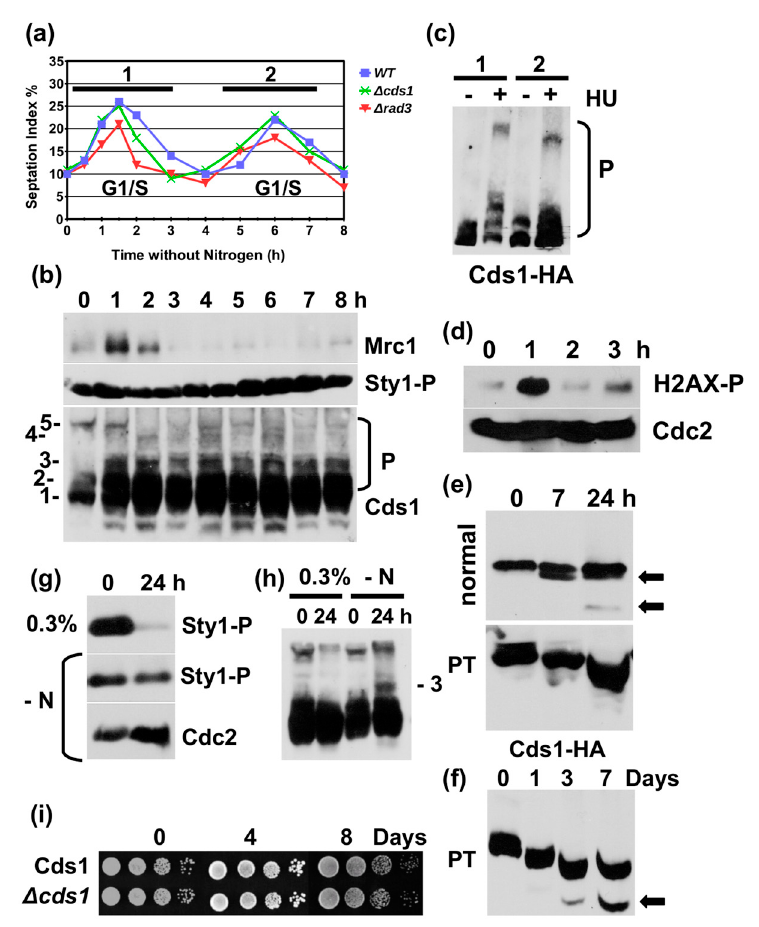
Figure 4. Nitrogen starvation causes similar changes to Cds1 and Mrc1. ( a ) Cds1-HA 2 His 6 , cds1 deletion and rad3 deletion strains without auxotrophic markers were grown in minimal medium with nitrogen overnight, washed and resuspended in minimal medium without nitrogen at 30 °C. The rise in the septation index (G1/S cells) shows the two rounds of DNA replication post-shift. ( b ) Total protein extracts tested at the indicated hours post-shift and probed for Mrc1, Sty1-T171P + Y173P and Cds1-HA 2 His 6 , (P = phosphorylated Cds1 protein on phostag SDS page), ( c ) Phostag SDS page of Cds1-HA 2 His 6 . Twelve mM HU was added at 20 min (1) post-shift or 4 h (2) post-shift. Cells were harvested 2 h later. ( d ) Total protein extracts analysed at the indicated hours post-shift and probed for H2AX-S129-P and Cdc2. ( e ) Normal and phostag (PT) SDS page of Cds1-HA 2 His 6 , harvested 0 h, 7 h and 24 post-shift. ( f ) PT-SDS page of Cds1-HA 2 His 6 cells, harvested at 0 h, 1 h, 3 h and 7 h (arrow = N-terminally truncated Cds1 form). ( g ) SDS page of Sty1-T171P+Y173P in 0.3% glucose or in minimal medium without nitrogen (-N) at 0 h and 24 h. ( h ) PT-SDS page of Cds1-HA 2 His 6 in 0.3% glucose or in minimal medium without nitrogen (-N) at 0 h and 24 h (3 = phosphorylated form). ( i ) Survival of the indicated strains in minimal medium without nitrogen.